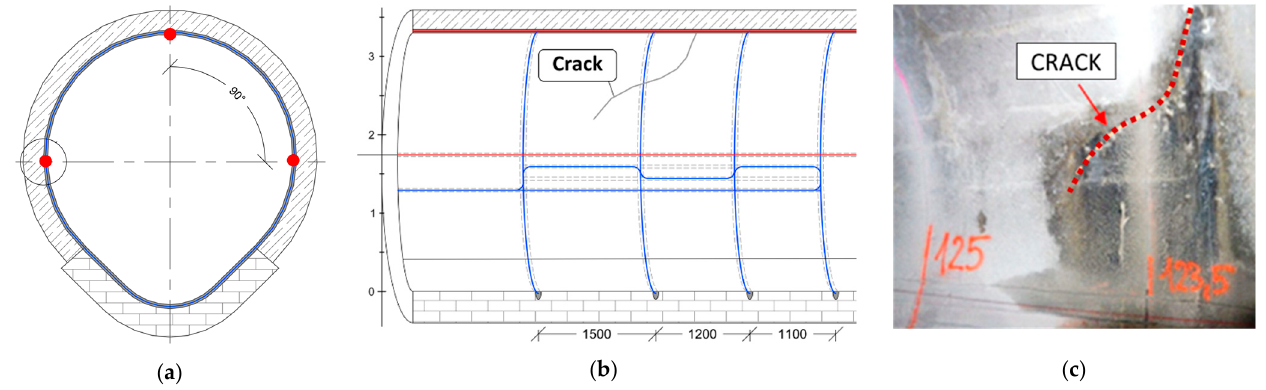
Figure 23. ( a ) Cross-section of the collector [58]; ( b ) location of the circumference monolithic sen- sor [58]; ( c ) the view of the crack documented before installation.